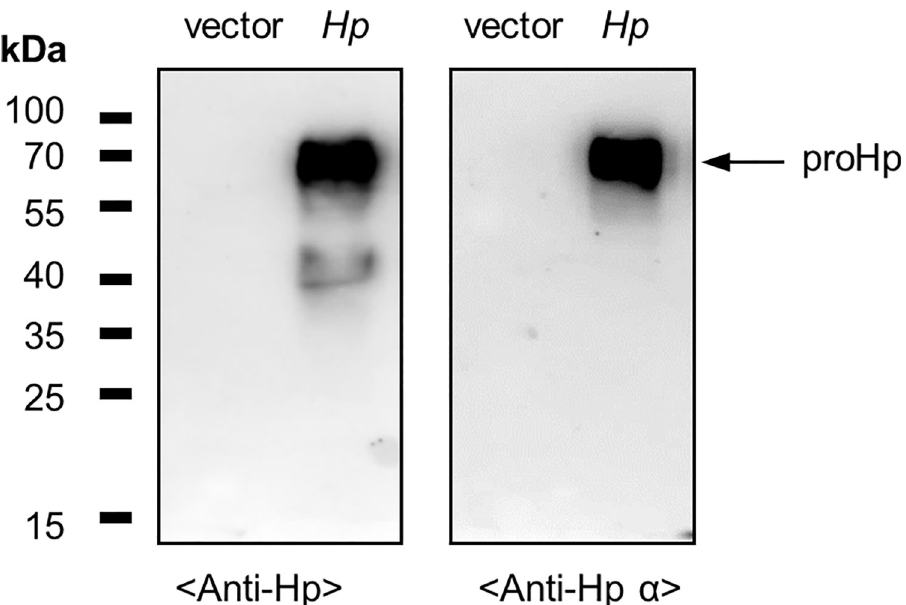
Fig 1. Identification of proHp in the CM of Hp gene-transfected SK-Hep1 cells. SK-Hep1 cells were transfected with vehicle vector DNA (vector) or vector containing human Hp2 cDNA ( Hp ) using Lipofectamine 2000. After cells had been cultured for 48 h in serum-free DMEM, Hp protein released into CM was detected by Western blotting using anti-Hp and anti-Hp α -chain antibodies. Note that the produced protein is the precursor proHp.